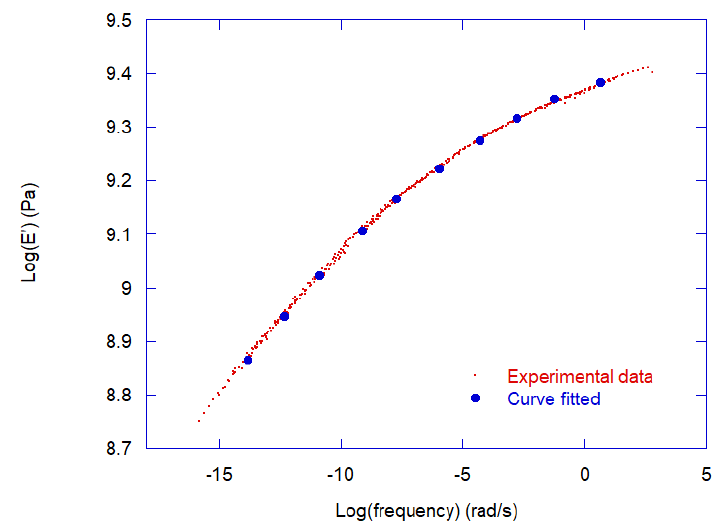
Figure 16. Master storage modulus of Polymer C.